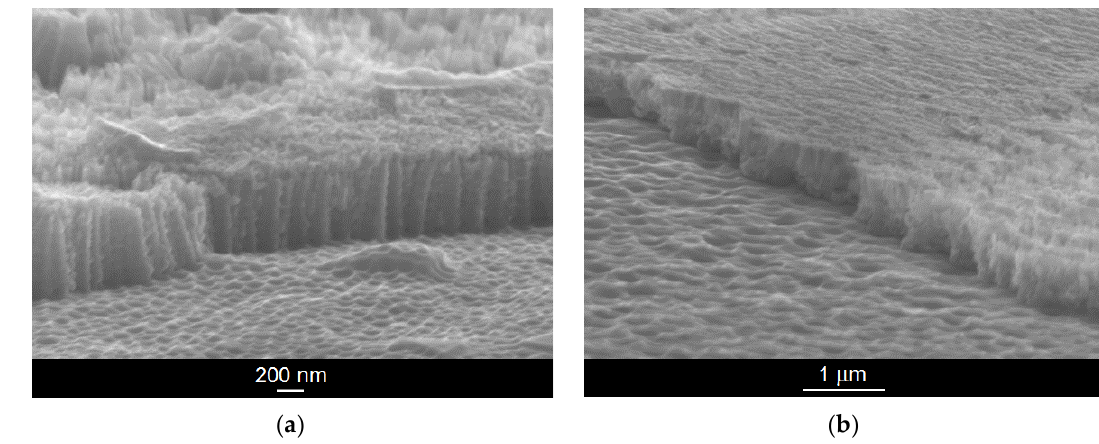
Figure 3. SEM image of the fracture of oxide nanotube (ONT) layer formed on the Ti–6Al–7Nb alloy in 1 M EG + 0.2 M NH 4 F electrolyte under anodizing conditions: ( a ) 30 V for 45 min; ( b ) 70 V for 20 min.